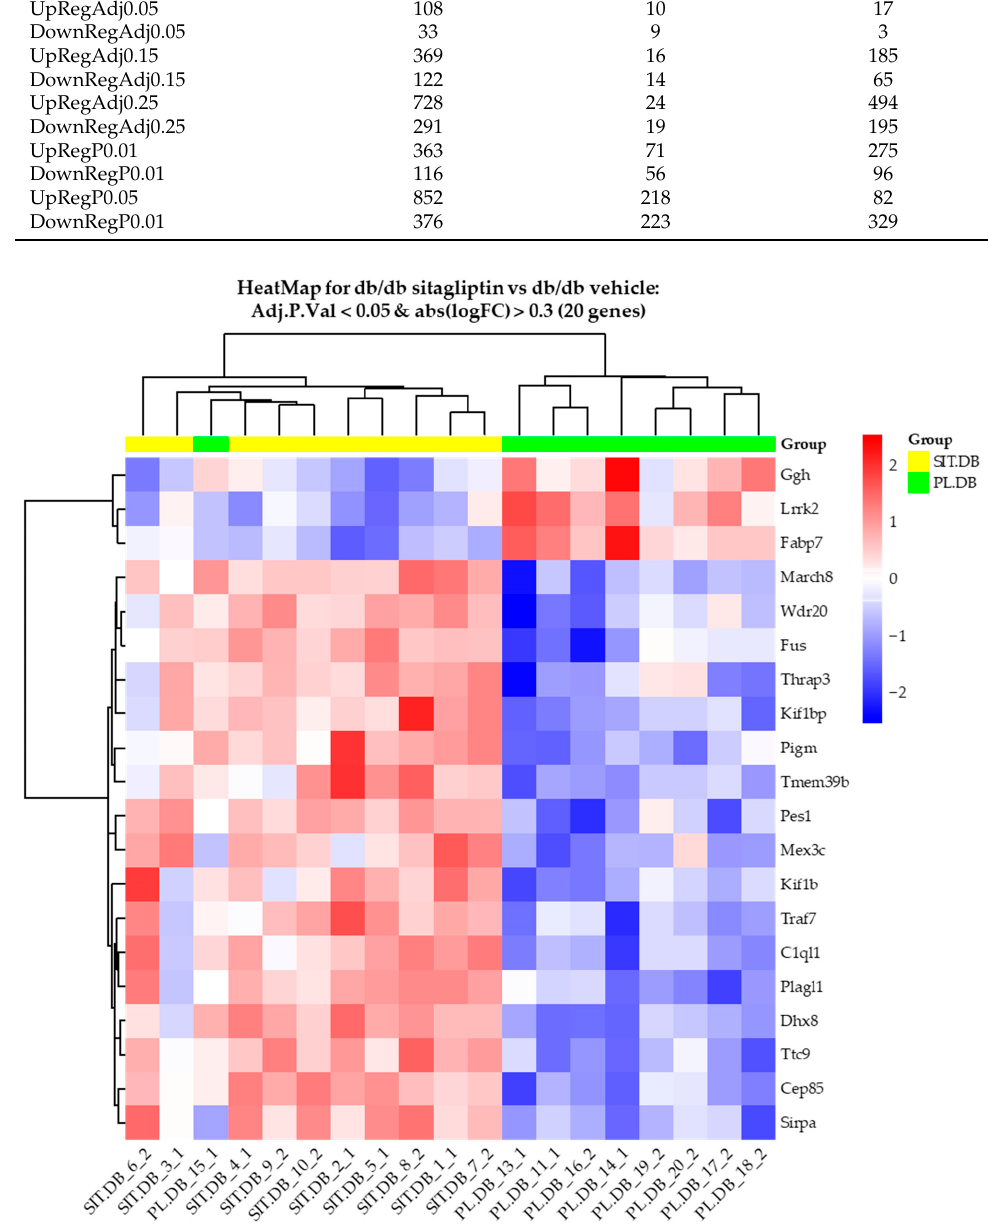
Figure 1. Comparison of retinal expression patterns between sitagliptin-treated and vehicle-treated db/db mice. ( A ) HeatMap for comparison of sitagliptin-treated db/db mice and vehicle-treated db/db mice with genes with an adjusted p -value of less than 0.05 and an absLogFC greater than 0.3 (20 genes). High and low row z-scores are represented in red and blue, respectively ( n = 10).